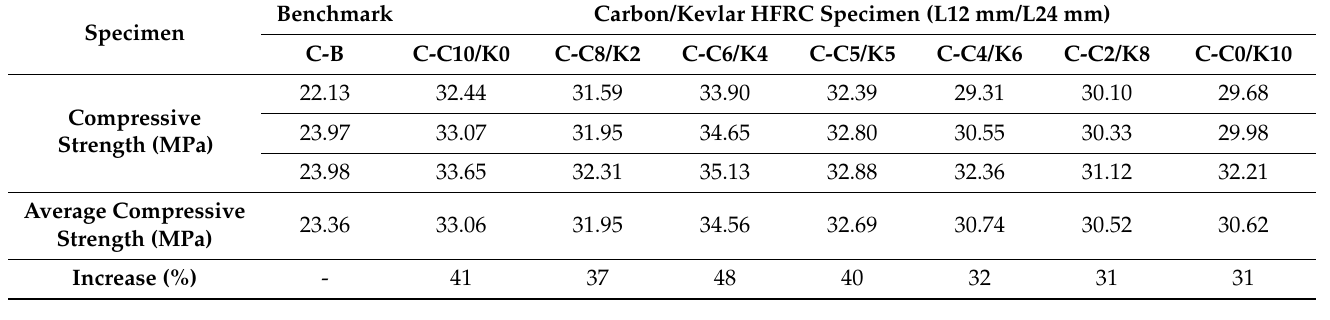
Table 5. Compressive strengths of benchmark and carbon/Kevlar HFRC specimens.